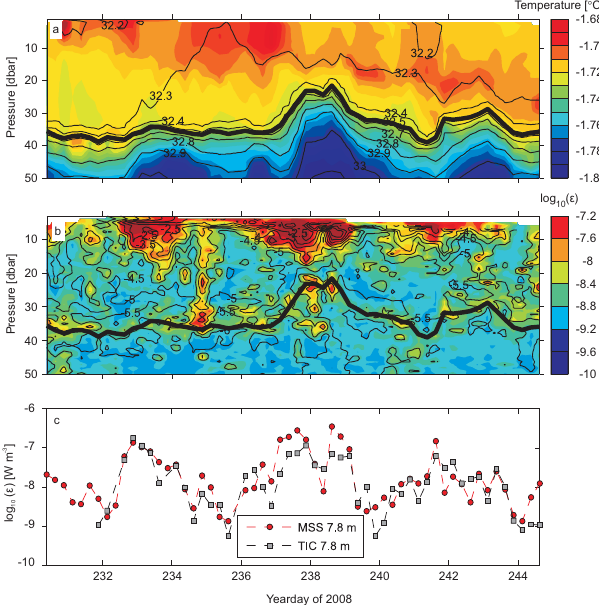
Fig. 6. Contour plot of (a) temperature (colour) and salinity (black) and (b) dissipation rate of turbulent kinetic energy, log 10 (ε) (colour) and eddy diffusivity of mass, log 10 ( K ρ ) (black) for the upper 50m. Thick black line in both panels indicates the base of the mixed layer. (c) Dissipation rate of turbulent kinetic energy, log 10 (ε) , estimated from MSS and TIC at 7.8m depth.